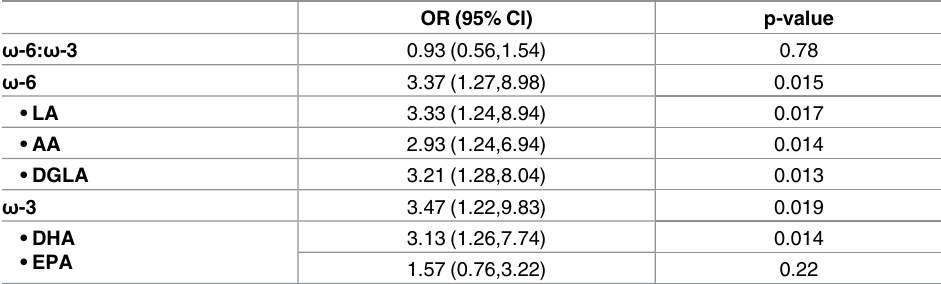
Table 3. Odds Ratio (95% Confidence Interval) of Pathological High Grade Disease( (cid:21) 4+3). OR (95% CI) p-value ω -6: ω -3